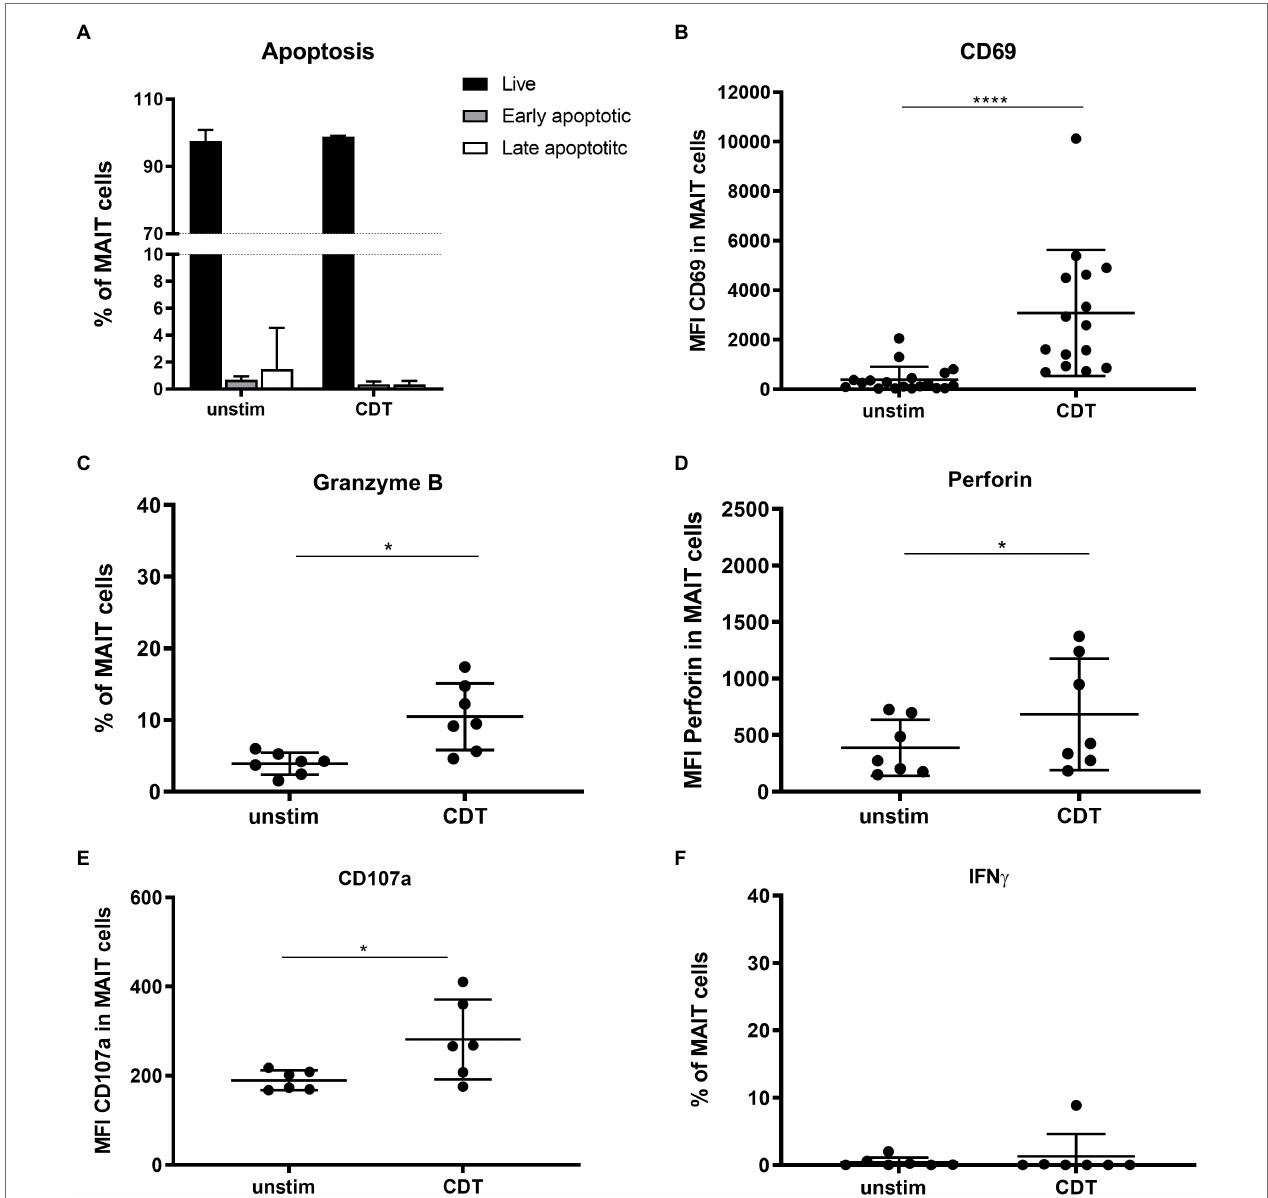
FIGURE 3 | Effector phenotype of primary human MAIT cells following stimulation with C. difficile CDT. PBMCs were isolated from healthy donors and stimulated with 100 ng/ml CDT for 20 h followed by flow cytometric analysis of apoptosis (A) , granzyme B (B) , CD69 (C) , perforin (D) , CD107a (E) and IFN γ expression (F) . Cells were gated on CD161 ++ V α 7.2 + CD3 + T cells (MAIT cells). (A) Live: Annexin V − and 7-AAD − (black), early apoptotic Annexin V + and 7-AAD − (dark grey), and late apoptotic Annexin V + and 7-AAD + (white) MAIT cells are depicted. Horizontal lines indicate mean ± SD. Asterisks indicate significant differences determined by Wilcoxon matched-pairs signed rank test: * p < 0.05, **** p < 0.0001. Data represent nine independent experiments from 6 to 15